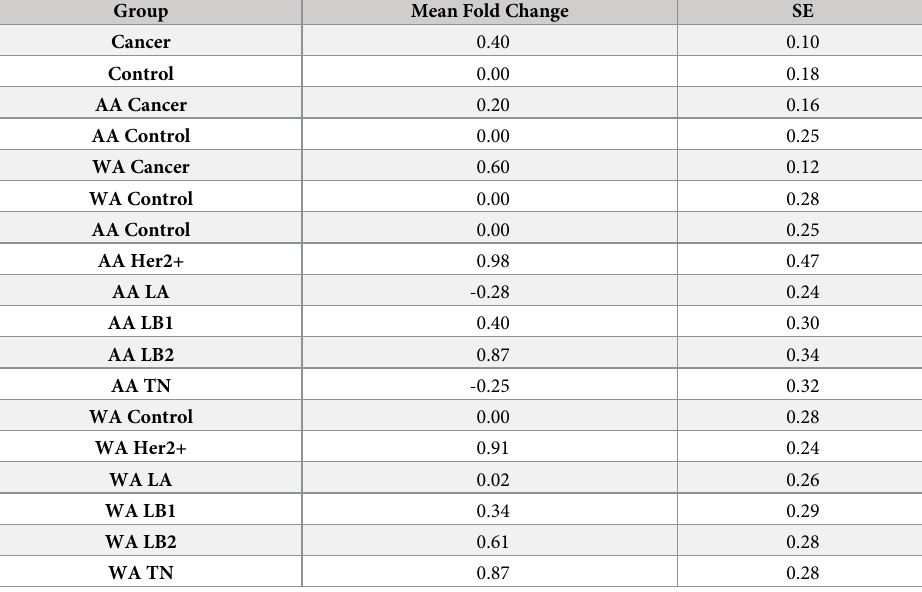
Table 2. Displays mean fold change and standard error (SE) from the RPPA dataset, comparing race and tumor subtypes to the control group. Data allows us to compare level of vitronectin in serum. The mean fold change is rela- tive to the control population for the same